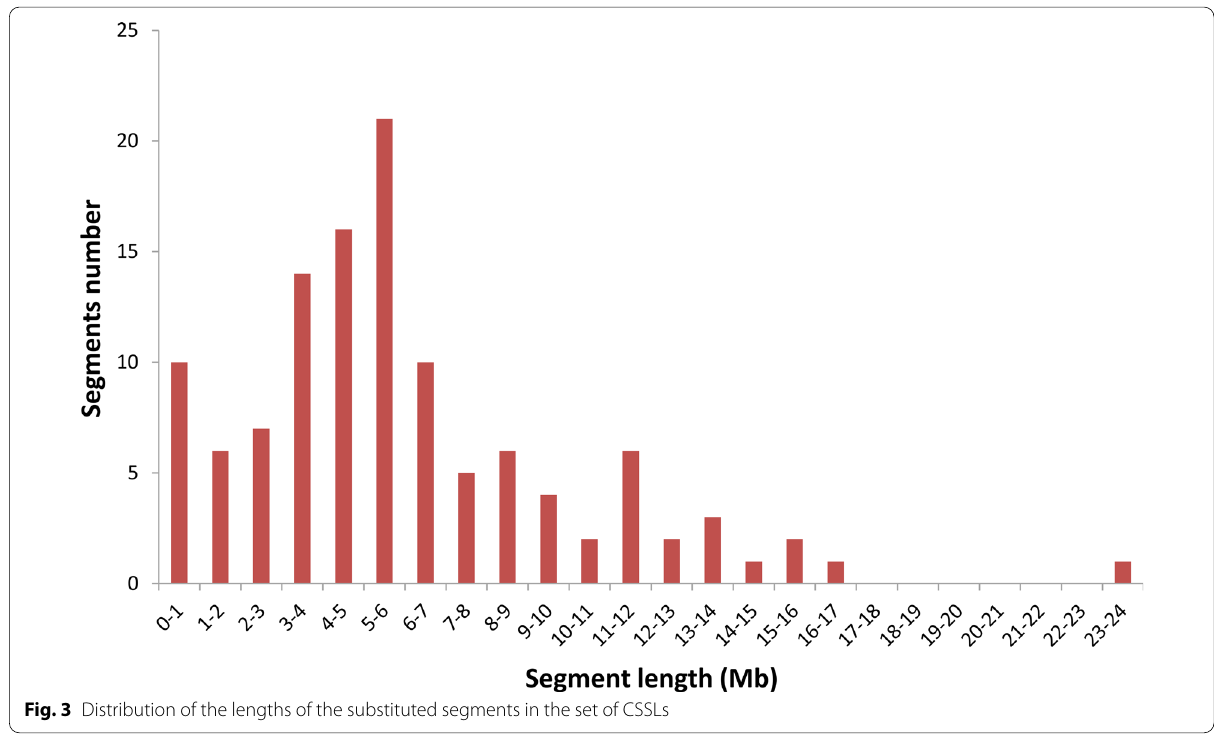
Fig. 3 Distribution of the lengths of the substituted segments in the set of CSSLs